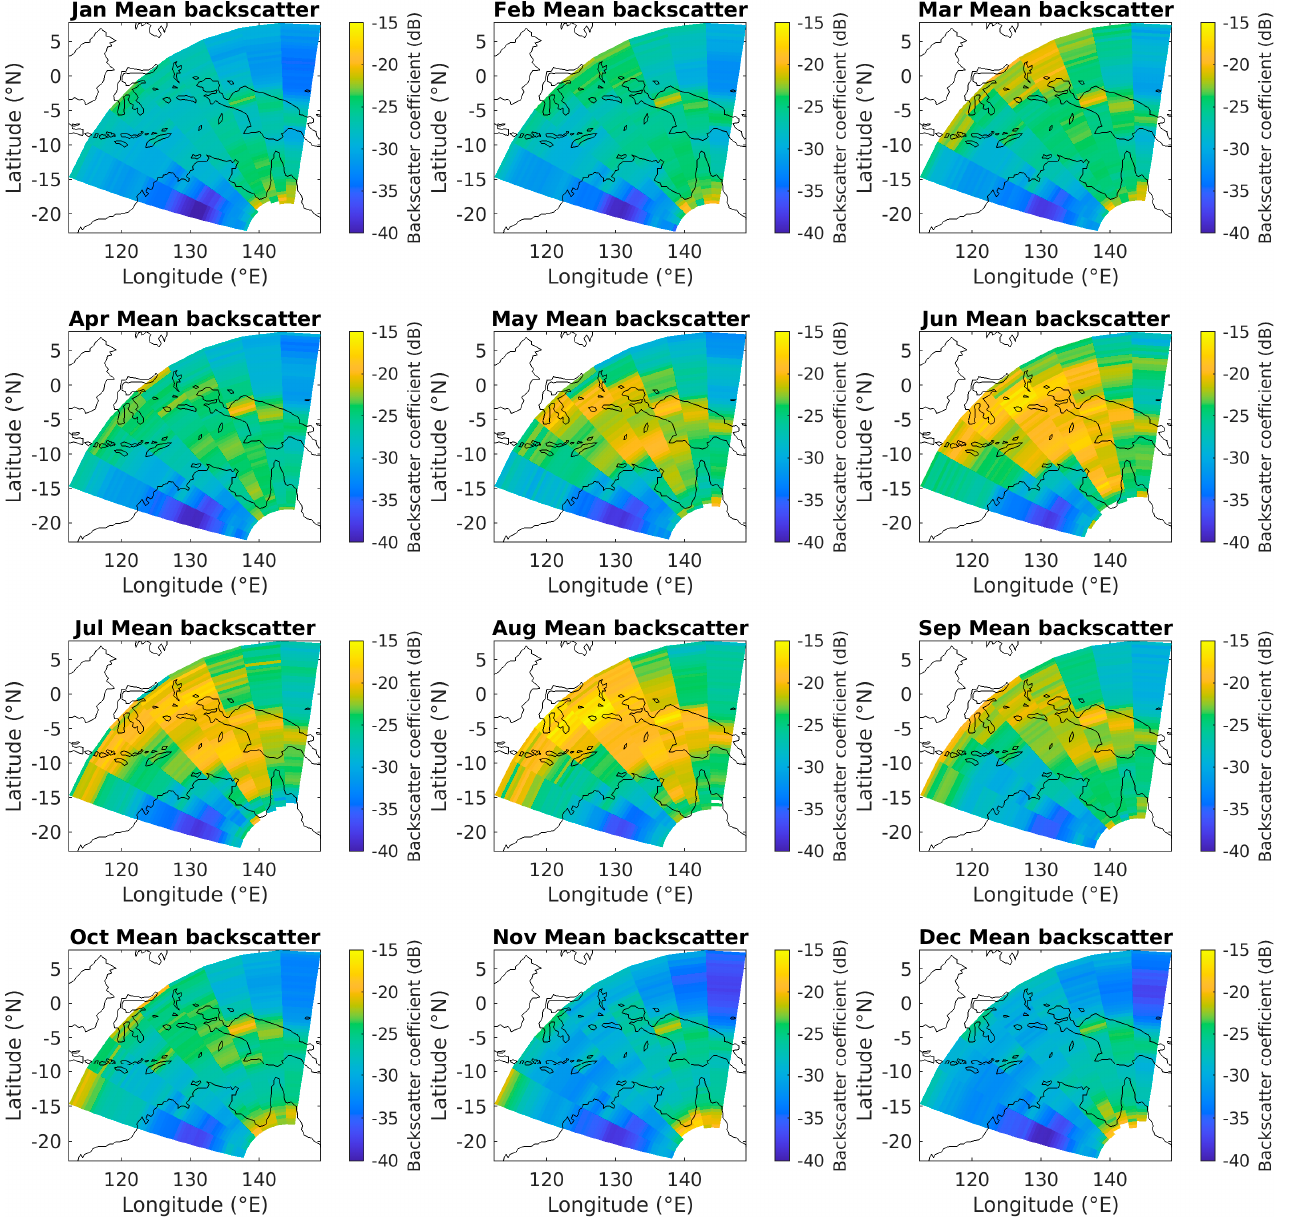
Figure 17. Decade mean of the monthly backscatter coefficients for LO.